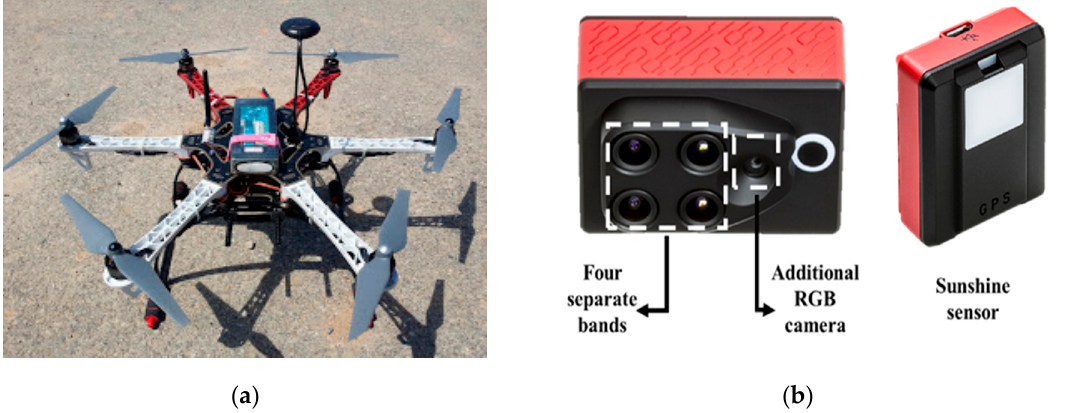
Figure 2. Views of ( a ) the manufactured unmanned aerial vehicle and ( b ) the commercial multi-spectral camera with sunshine sensor.